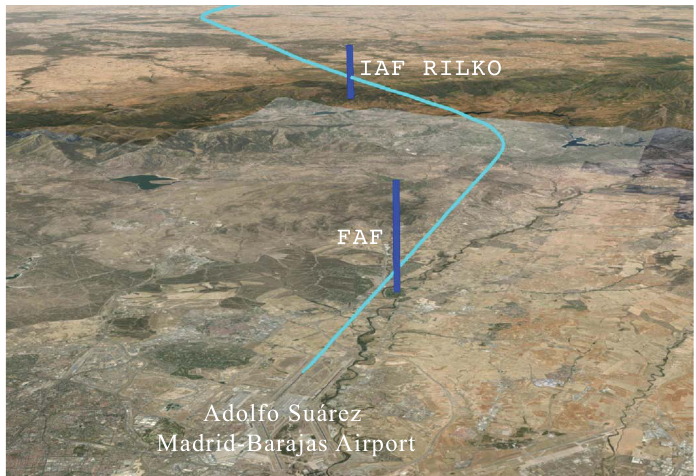
Figure 2. VWP estimation framework. The cyan trajectory represents the final approach path of an aircraft landing. Blue vertical lines represent the locations where wind profiles are